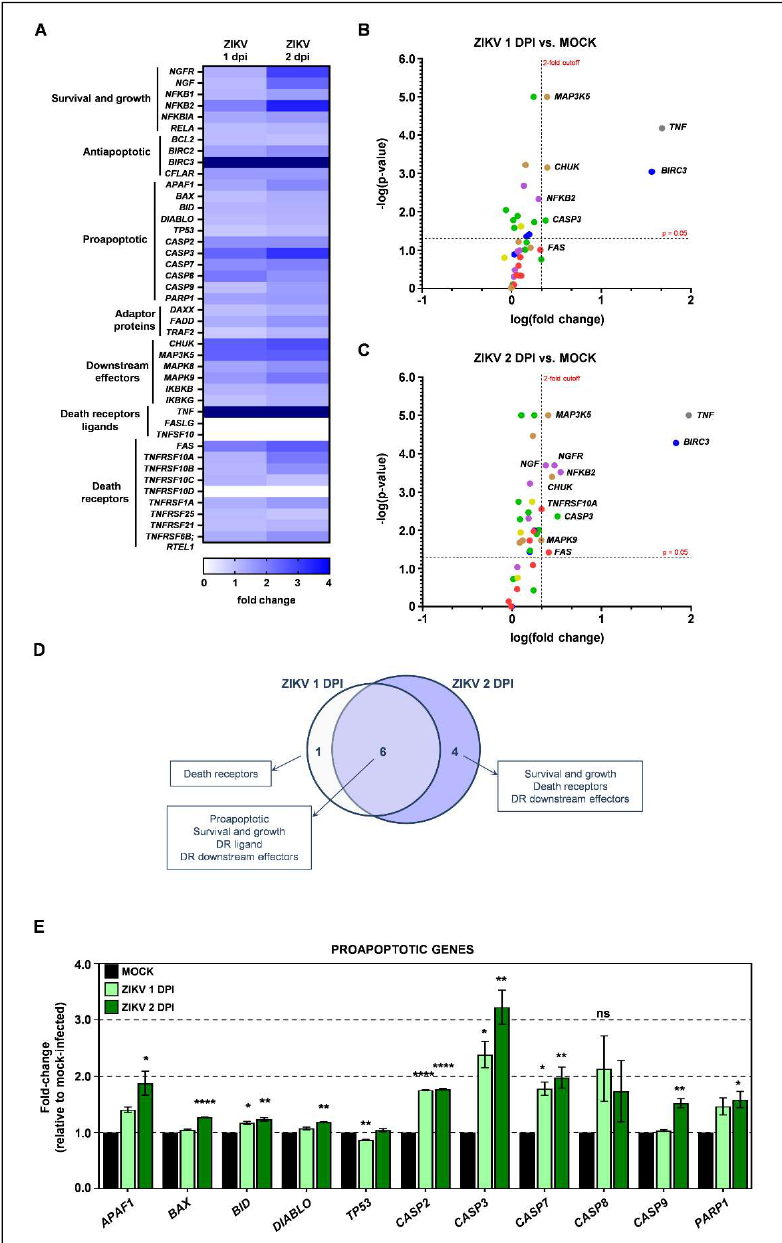
Figure 2. ZIKV infection modulates the expression of genes related to cell survival and cell death pathways. Mock- and ZIKV-infected (MOI 5) SH-SY5Y cells were harvested and processed at 1 and 2 dpi for gene expression analysis by qPCR. ( A ) Fold-change heatmap of target genes. Color coding: white: gene expression not detected; dark blue: genes with fold-change of more than four-fold. ( B , C ) Volcano plots of fold-change with respective statistical significance analyzed at 1 dpi ( B ) and 2 dpi ( C ), according to unpaired t-test compared to mock-infected samples. Color coding: ( D ) Venn diagram showing numbers of genes with expression variation of more than two-fold at each or both of the analyzed timepoints and information on gene function. ( E ) Expression levels of proapoptotic genes at 1 (light green bars) and 2 dpi (dark green bars). Data represented as mean ± (SD) of one experiment performed in duplicate. Statistical analysis performed by one-way ANOVA followed by Tukey’s post-test. ns—non-significant, * p < 0.05, ** p < 0.01, **** p < 0.0001, according to Tukey’s post-test.